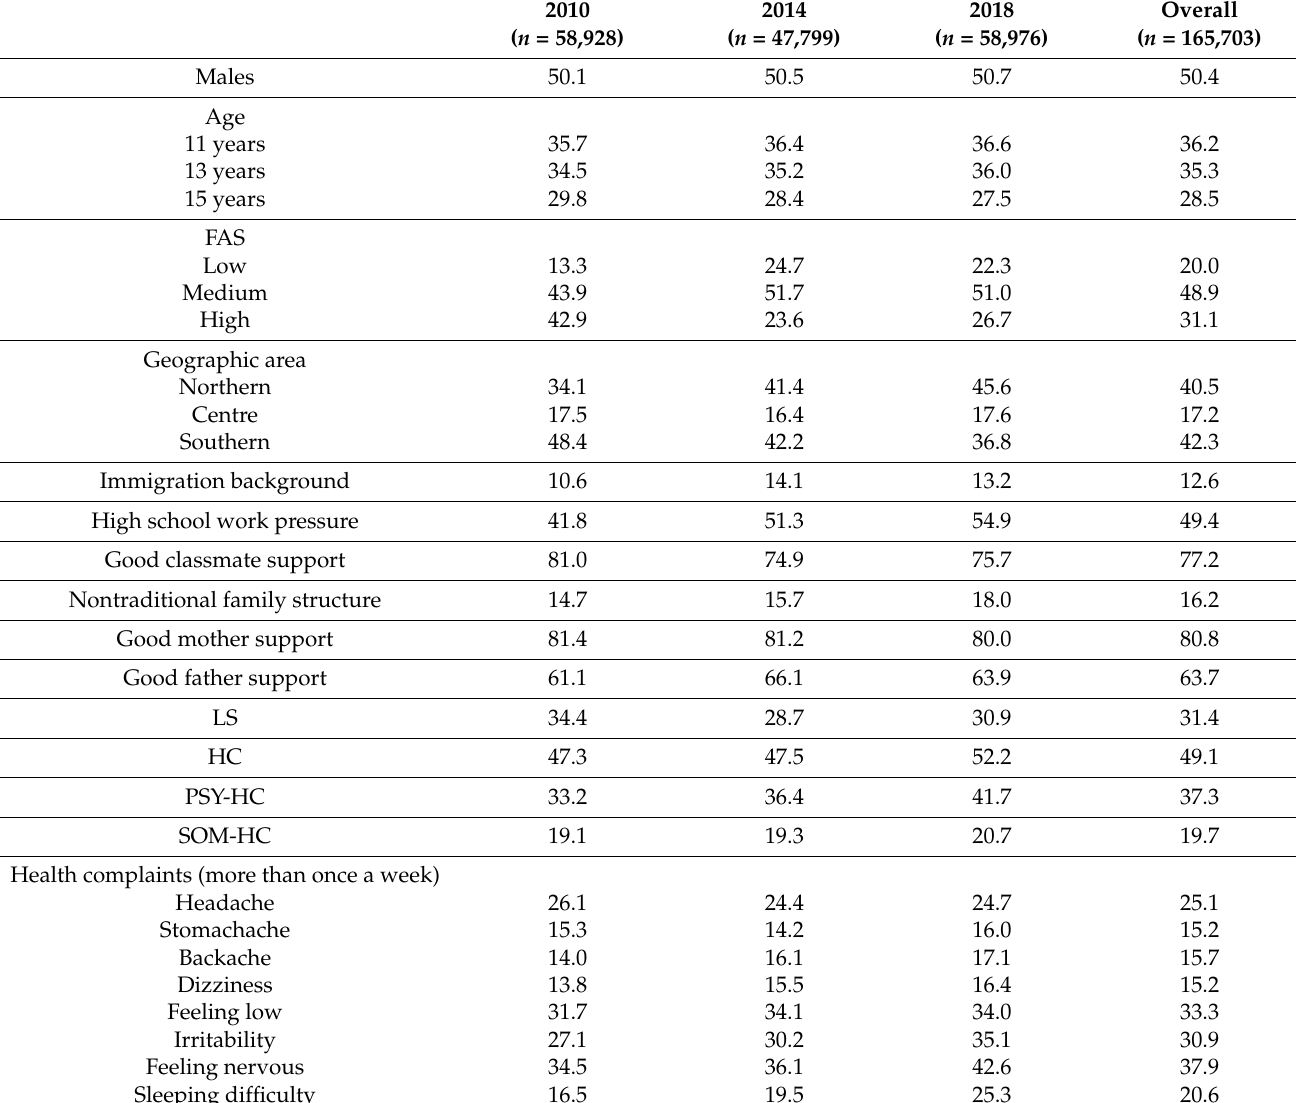
Table 1. Descriptive characteristics (%) of the total sample and across